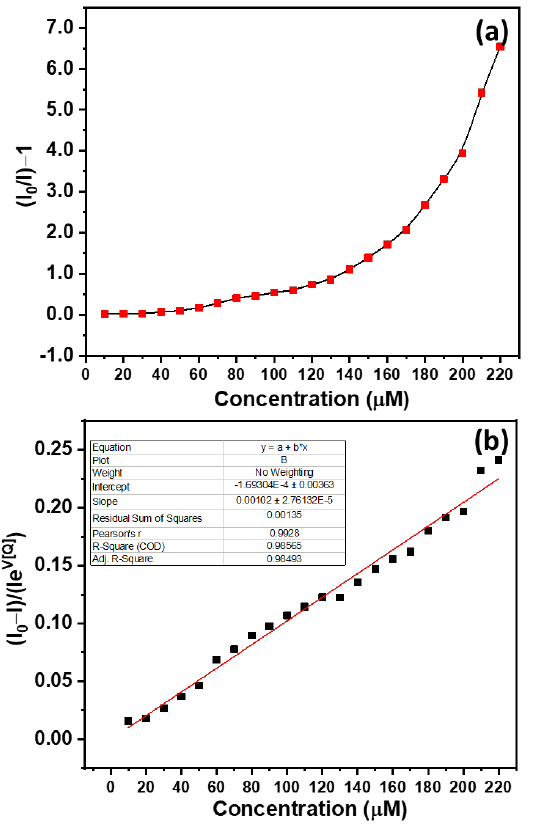
Figure 7. ( a ) Simple and ( b ) modified Stern – Volmer plots for the CdO-ZnO nanocomposites.